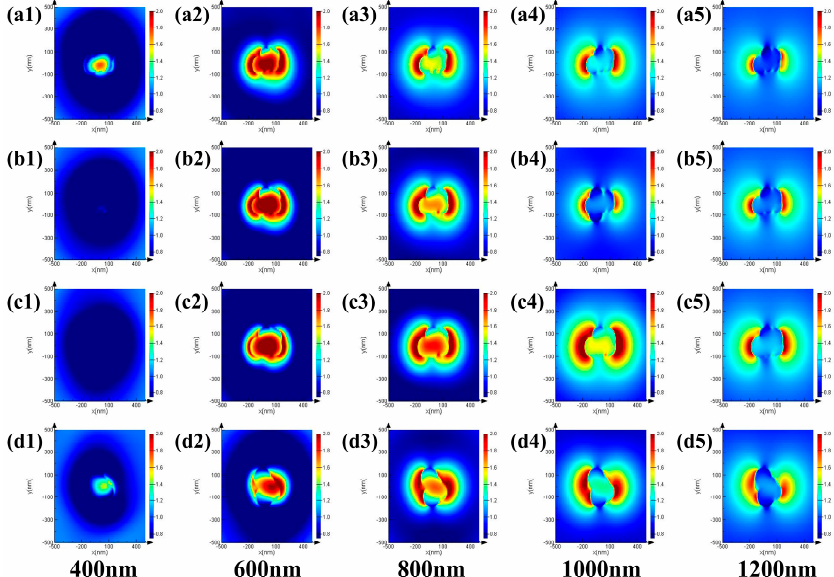
Figure 6. FDTD simulation of electric field distribution of ( a1 – a5 ) CCC-1, ( b1 – b5 ) CCC-2, ( c1 – c5 ) CCC-3, and ( d1 – d5 ) CCC-4 at different radiation wavelengths (400 nm, 600 nm, 800 nm, 1000 nm, and 1200